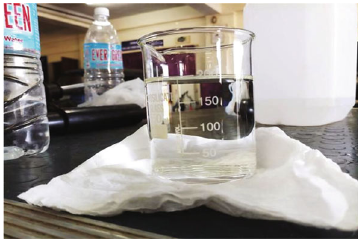
Figure 2: Preparation of amine